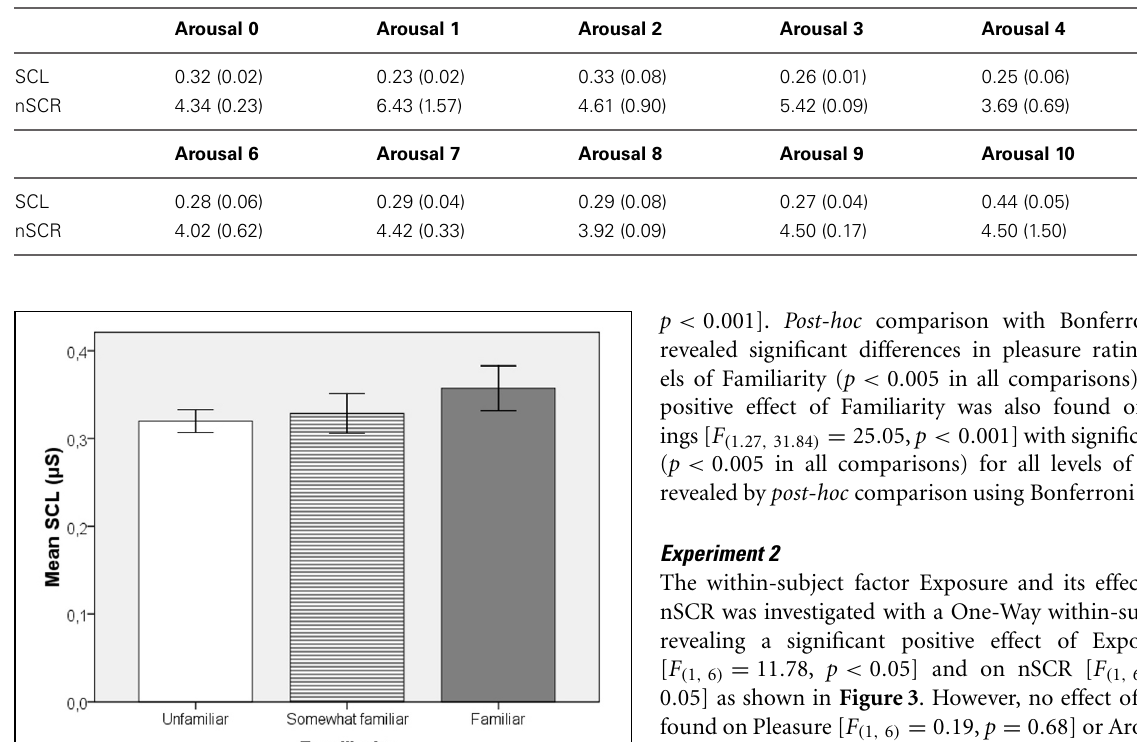
Table 3 | Mean SCL in µ S (SD) and nSCR (SD) values for arousal categories.